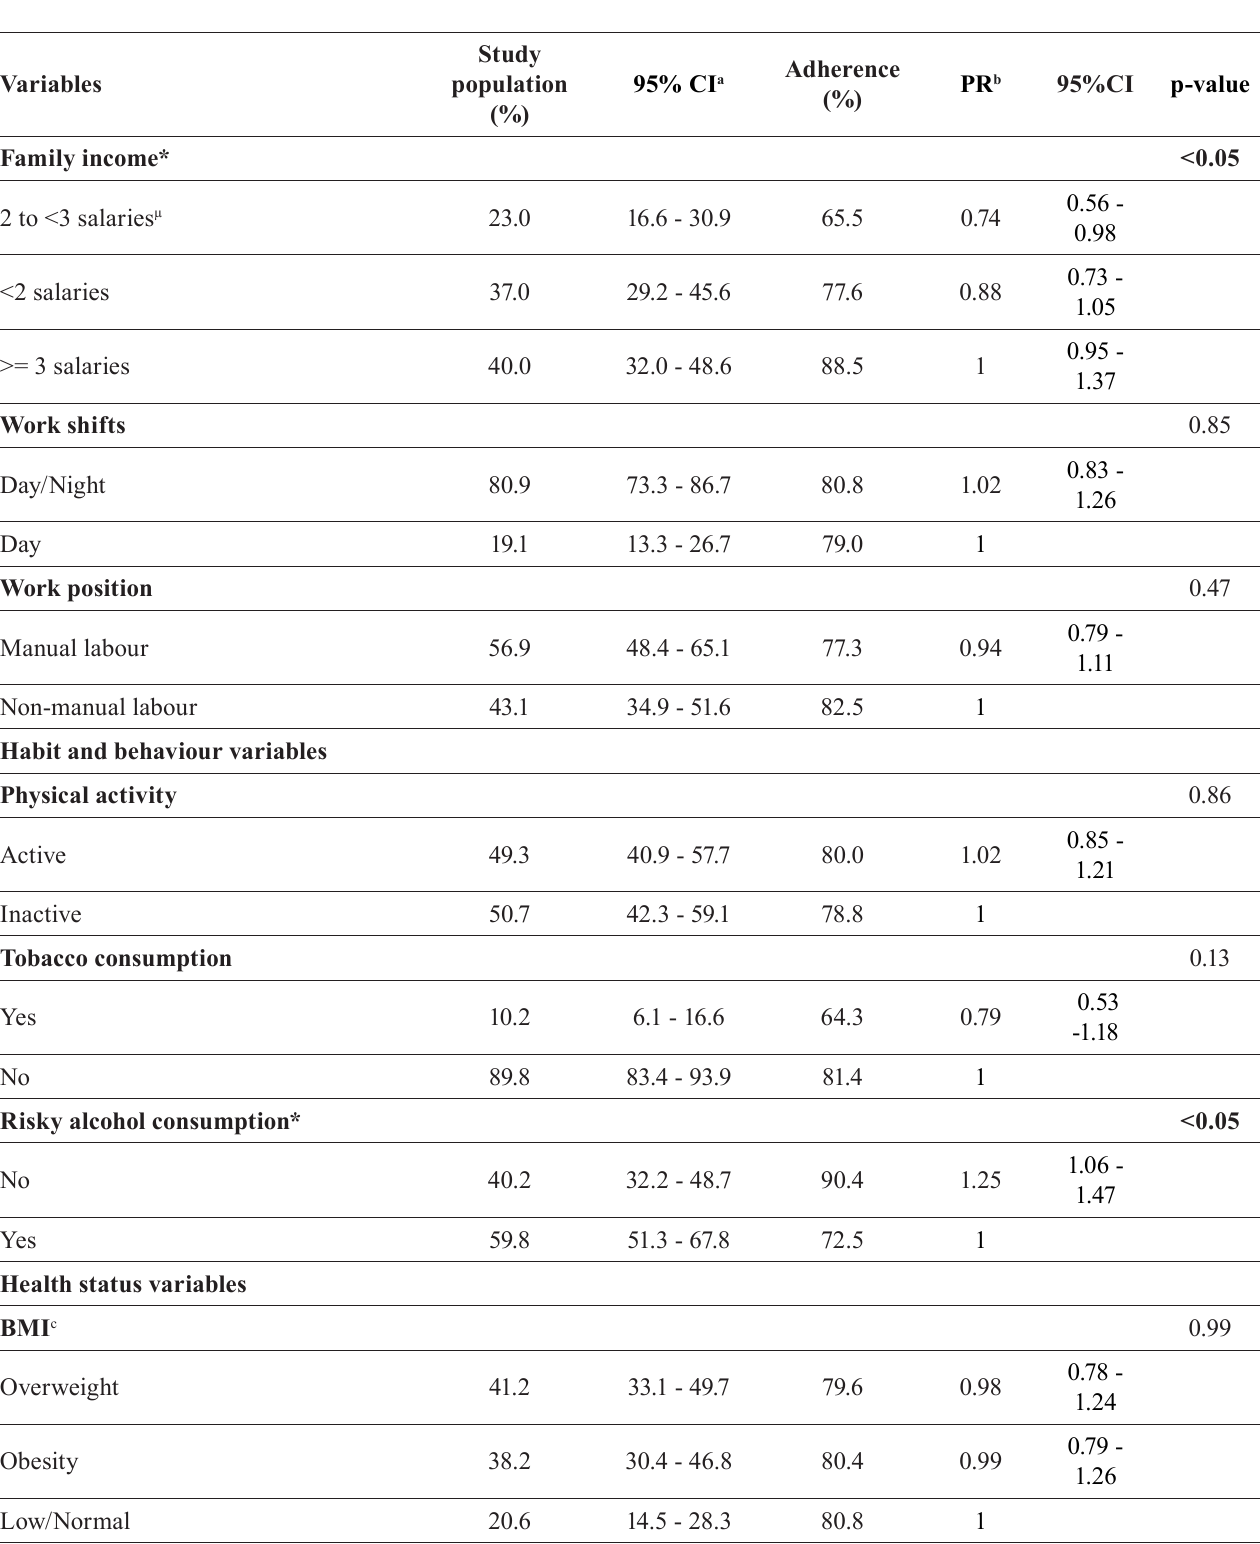
TABLE I - C haracteristics of the population of industry workers with hypertension and diabetes mellitus, prevalence of adherence and associated factors, 2017 to